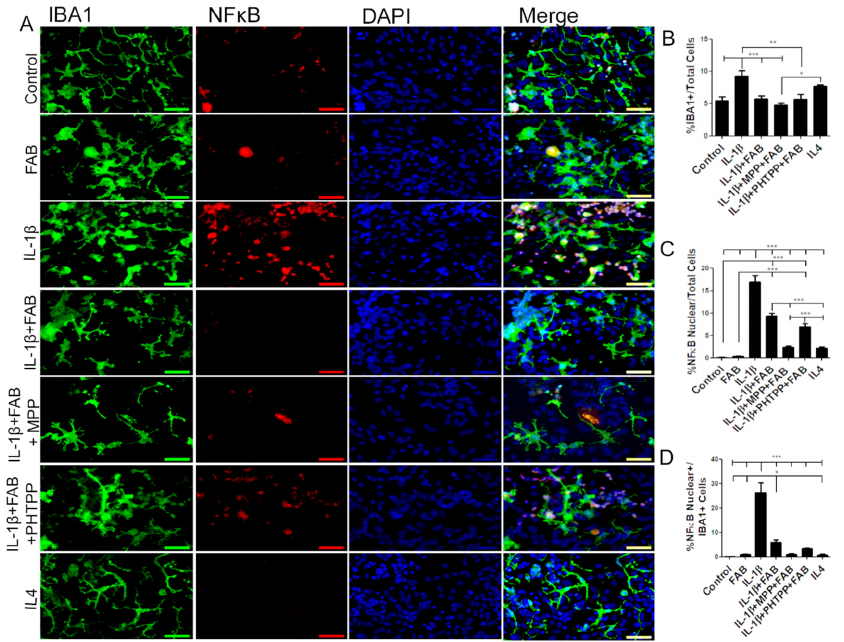
Figure 6. Agathisflavone protects against neuroinflammation induced by IL-1 β . ( A ) Representative photomicrographs of immunocytochemistry for Iba-1 (green) and the M1 microglial marker NF- κ B (red) counterstained with DAPI (blue) in cocultures; scale bar: 50 µ m. B-D. Bar graphs showing total as indicated; values are expressed as the mean ± SEM ( n = 3) and were tested for significance by one-way ANOVA. * p < 0.05, ** p < 0.01, and *** p <